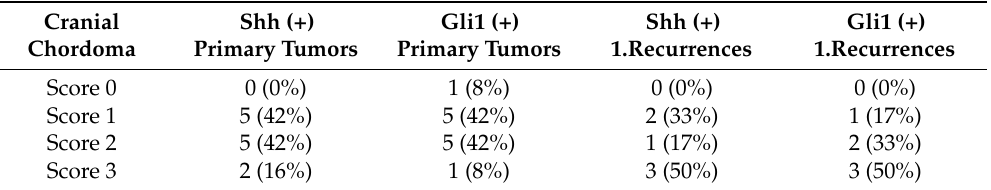
Table 3. Immunohistochemistry: Distribution and reaction strength of spinal chordomas in six patients and 18 samples divided into twelve primary tumors and six first recurrences.